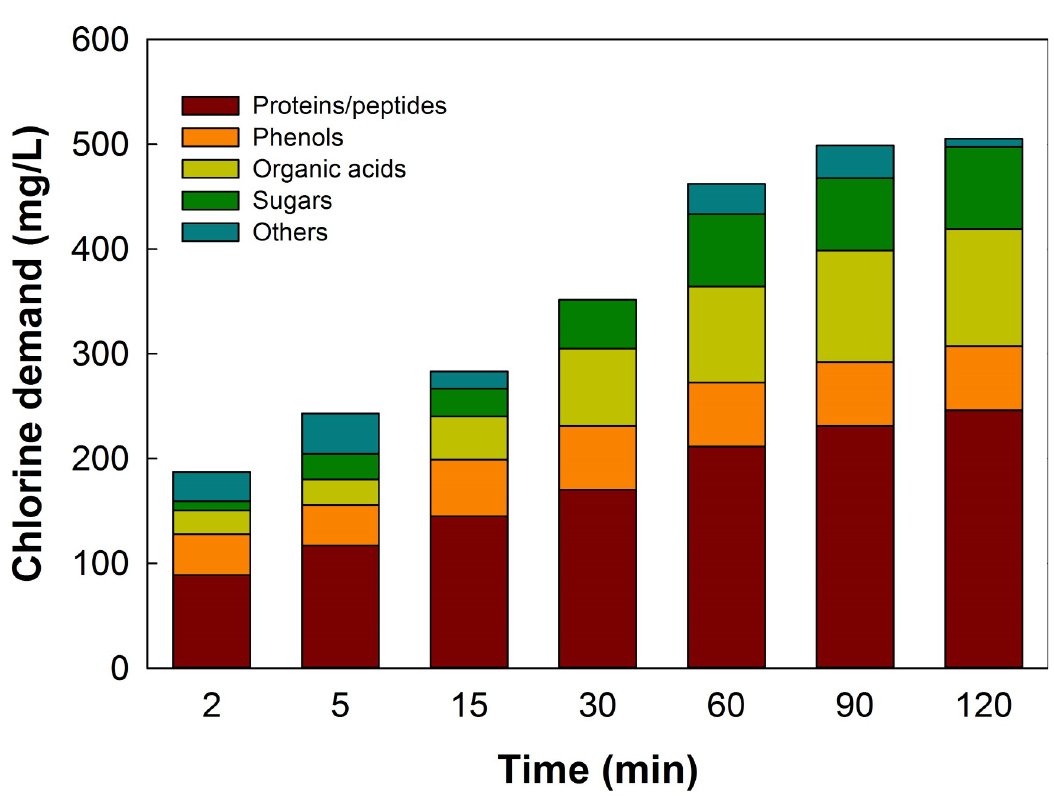
Fig 3. Time-dependent contribution to chlorine demand (CLD) by different compounds in cabbage wash water.